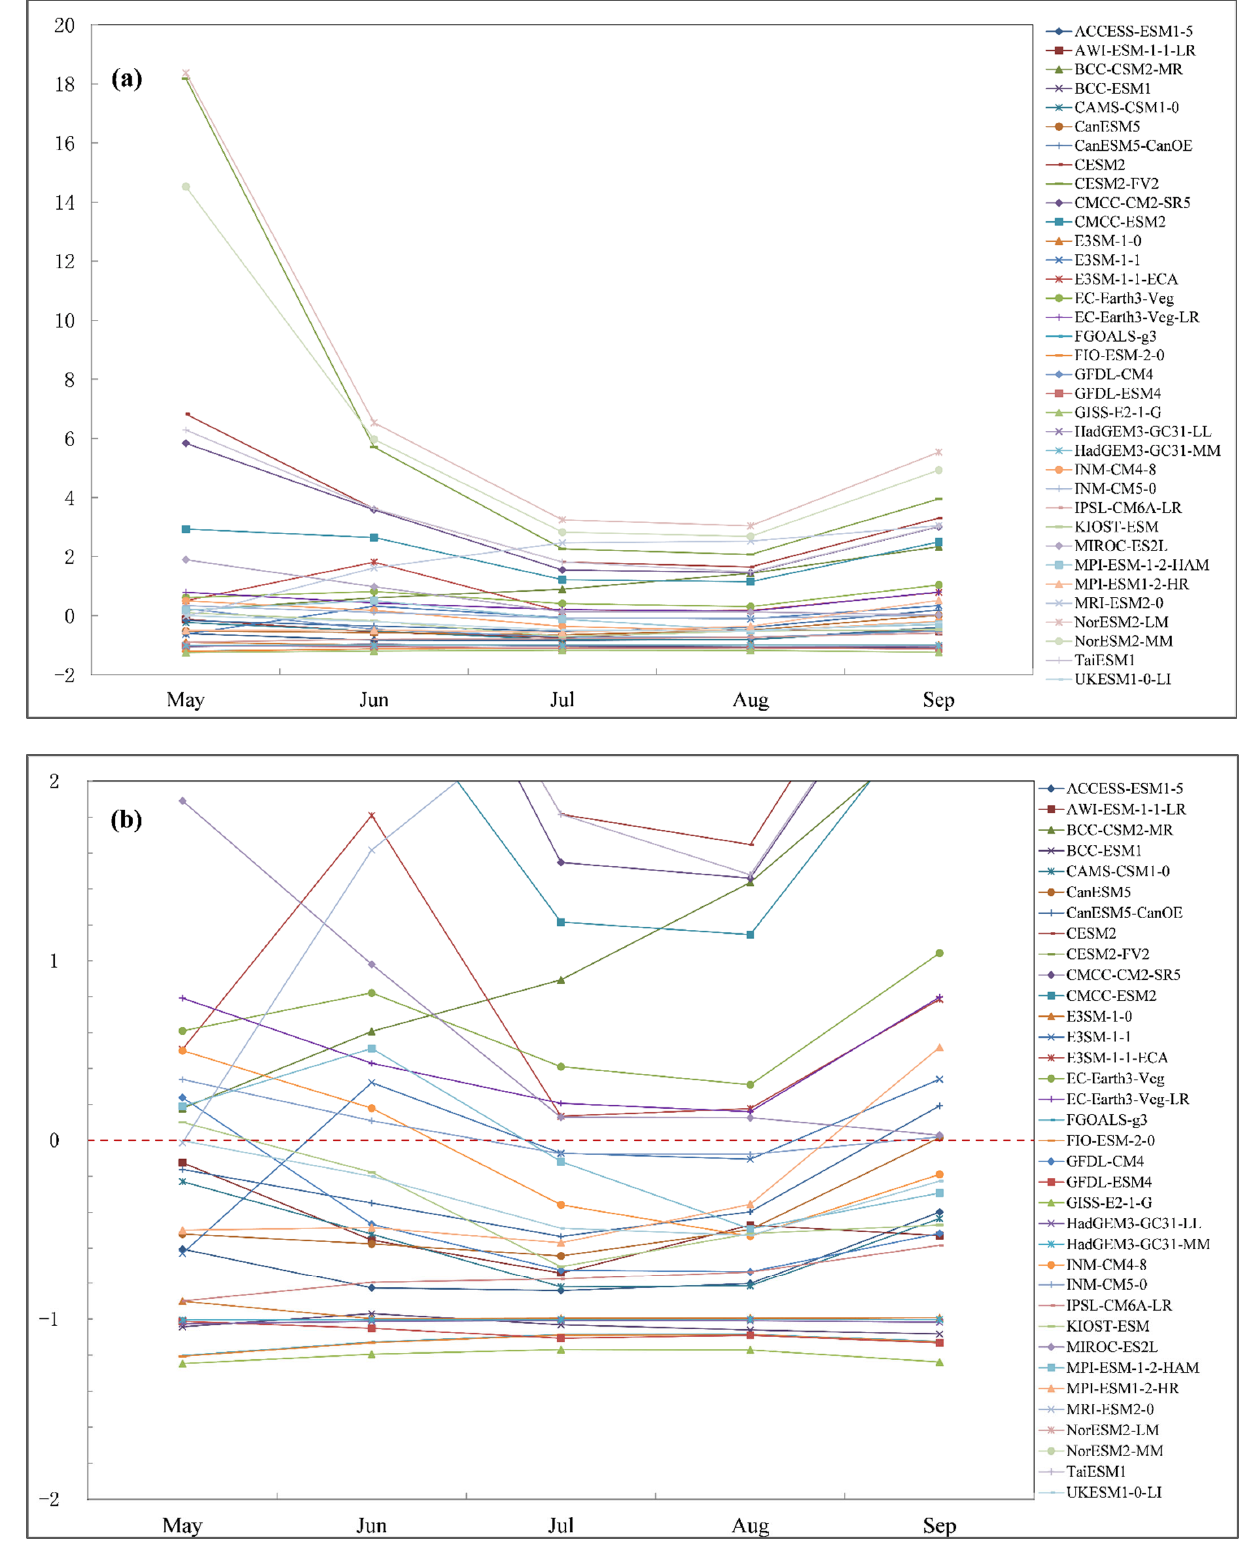
Figure 5. The ratio of the monthly LAI trend of the growing season between each CMIP6 model and the GLASS data. The y ‐ axis is from − 2 to 20 in ( a ), and from − 2 to 2 in ( b ).